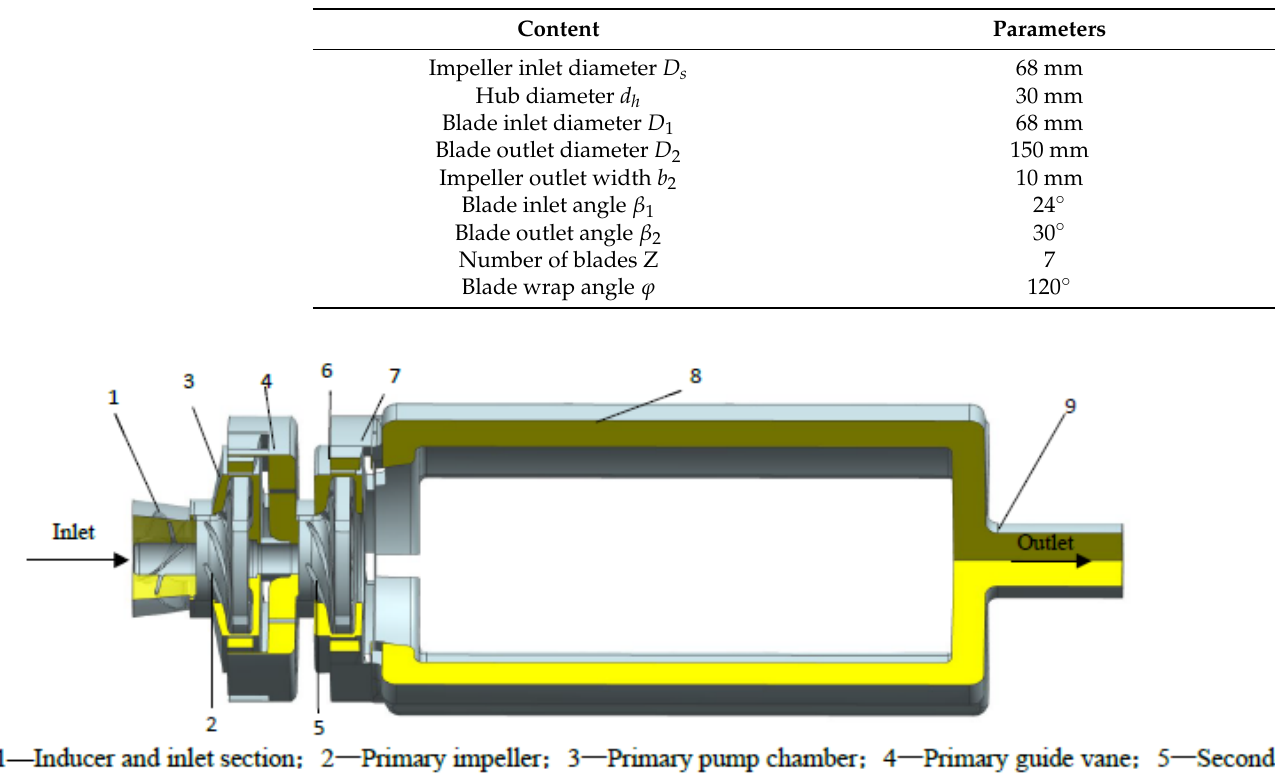
Figure 2. Distribution of the monitoring points in the impeller. ( a ) Primary impeller and ( b ) second- ary impeller.